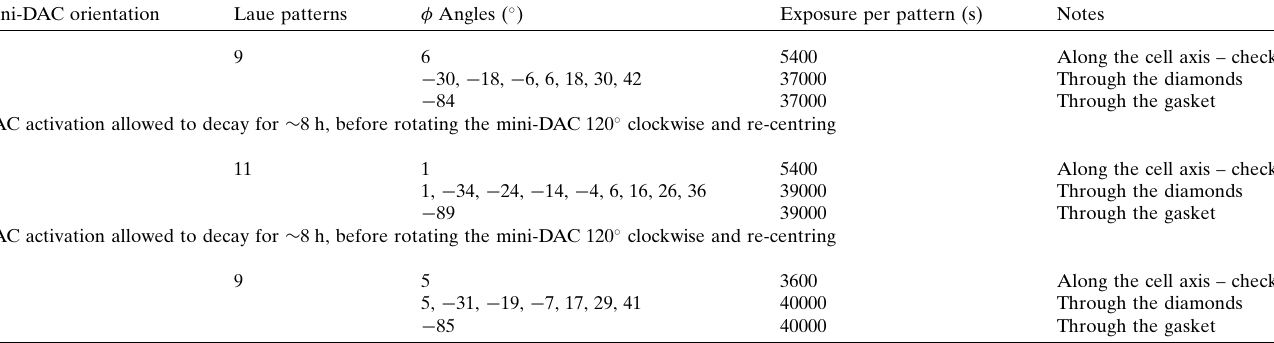
Table 1 Data collection strategy at ambient temperature, using the Koala Laue single-crystal diffractometer at ANSTO, for copper sulfate pentahydrate at 0.71